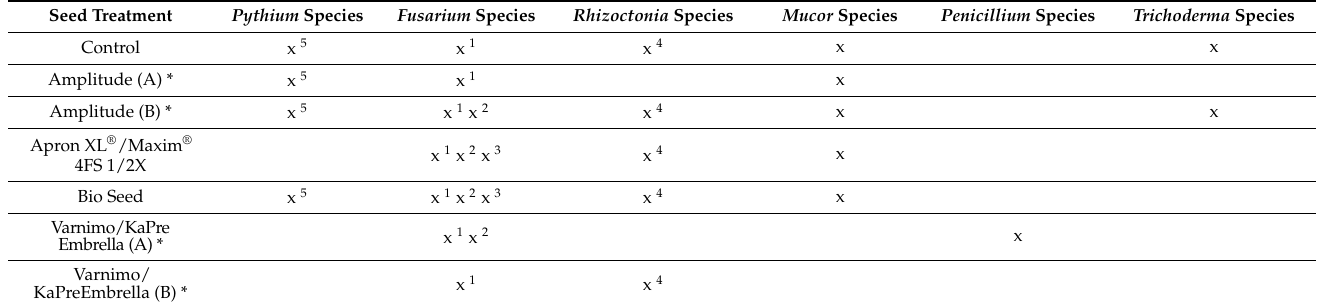
Table 6. Sample and positive identification of pathogens present on hemp seedlings in Ithaca, NY.